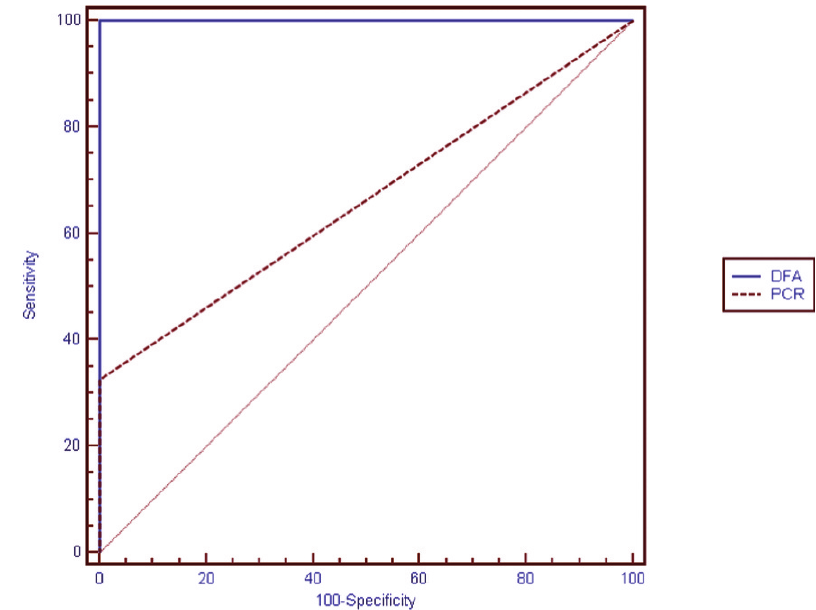
Figure 3 - ROC curves for DFA